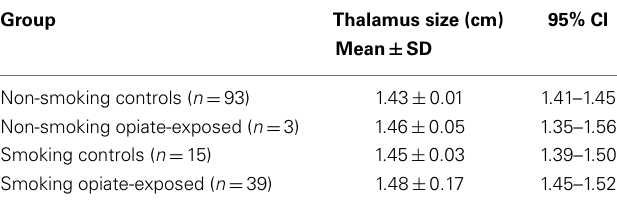
Table 4 | Descriptive analysis of thalamic diameter in four exposure groups: non-smoking controls, non-smoking opiate-exposed, smoking controls, and smoking opiate-exposed